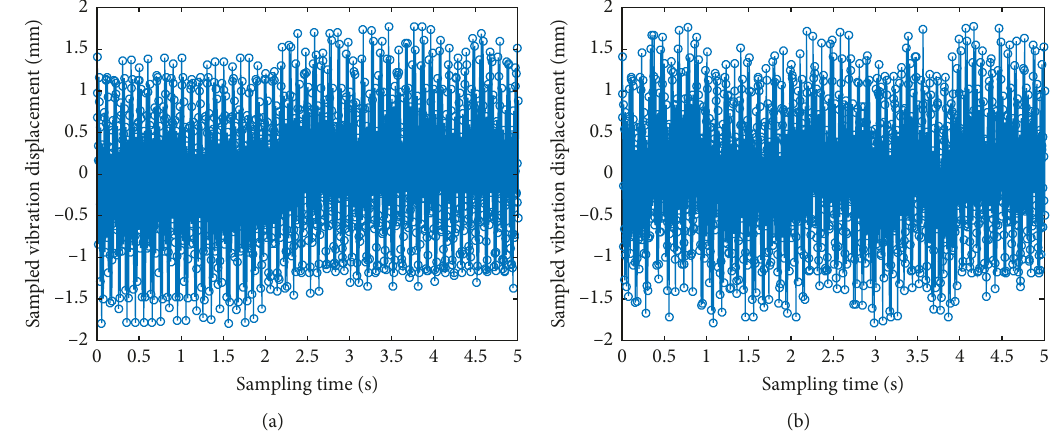
Figure 5: Sampled vibration displacements under rotating speed fluctuation: (a) URS � 3.16%; (b) URS �